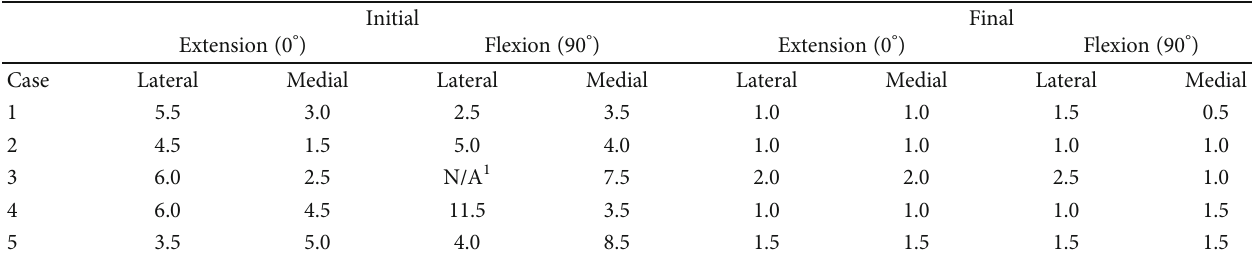
Table 2: The tibiofemoral lateral and medial gap spacing (mm) in both extension and fl exion in the initial evaluation of surgery as well as in the fi nal evaluation following bone resections when varus and valgus stress was applied, respectively.